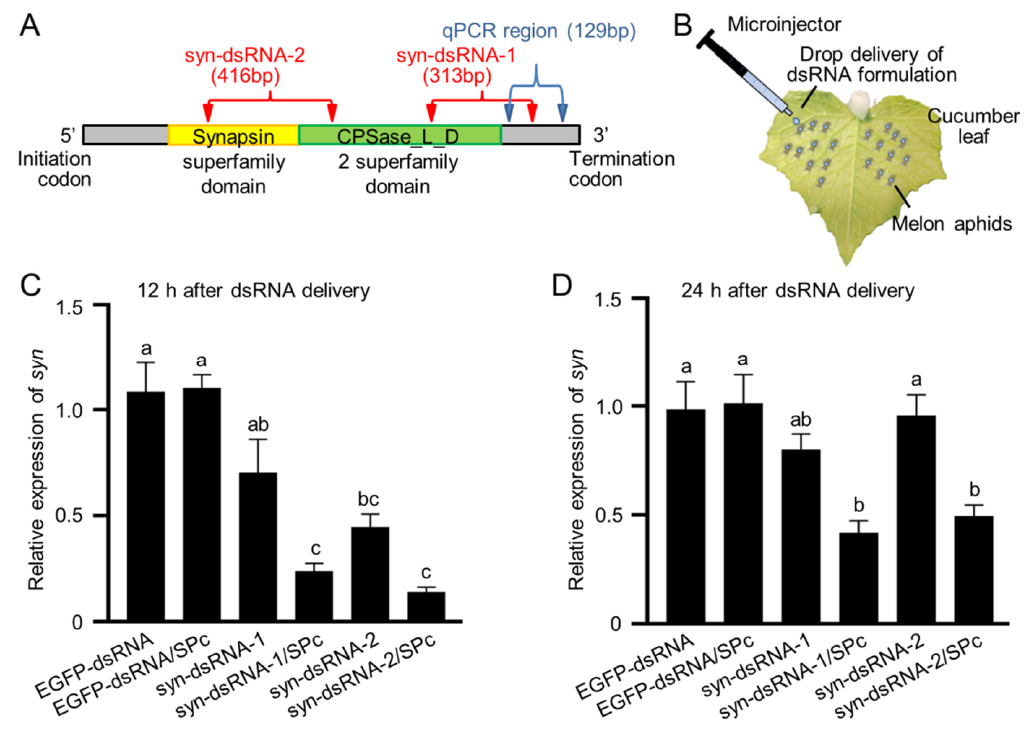
Figure 3. synapsin expression was regulated by syn-dsRNA. ( A ) The predicted protein structure of synapsin in the melon aphid. The syn-dsRNA targeting sites and qPCR amplicon are indicated. ( B ) Schematic diagram of transdermal delivery system of dsRNA formulations. ( C ) synapsin was downregulated by syn - dsRNA at 12 h after dsRNA delivery. ( D ) synapsin was downregulated in the presence of SPc at 24 h after dsRNA delivery. The letters above each column indicate significant differences (Tukey’s multiple comparison test, p < 0.05).